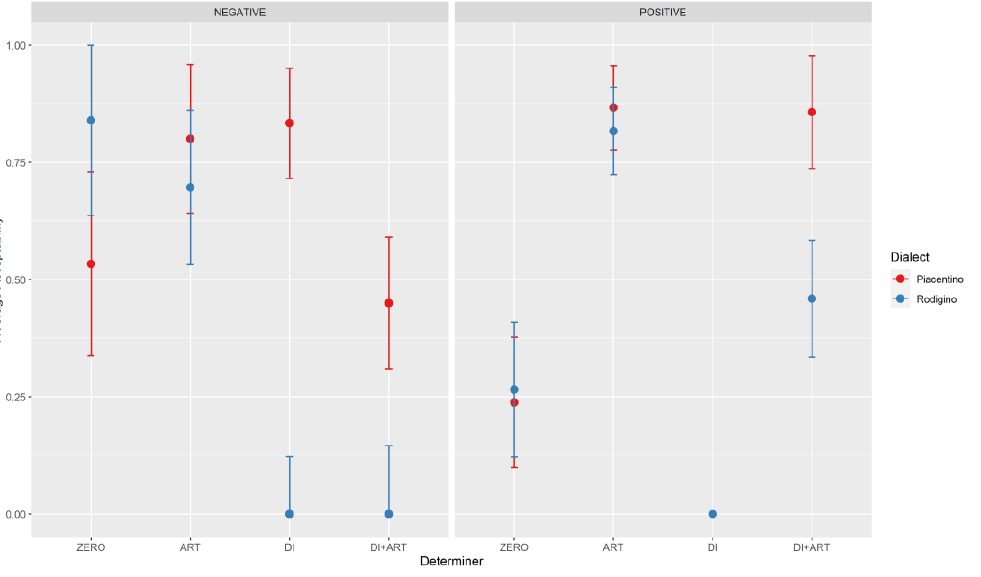
Figure 8. Average acceptability scores by determiner type and speaker’s dialect in a negative (left) or positive (right) sentence. For the sake of brevity and to avoid redundancy, only the acceptability scores from the by-subject analysis are